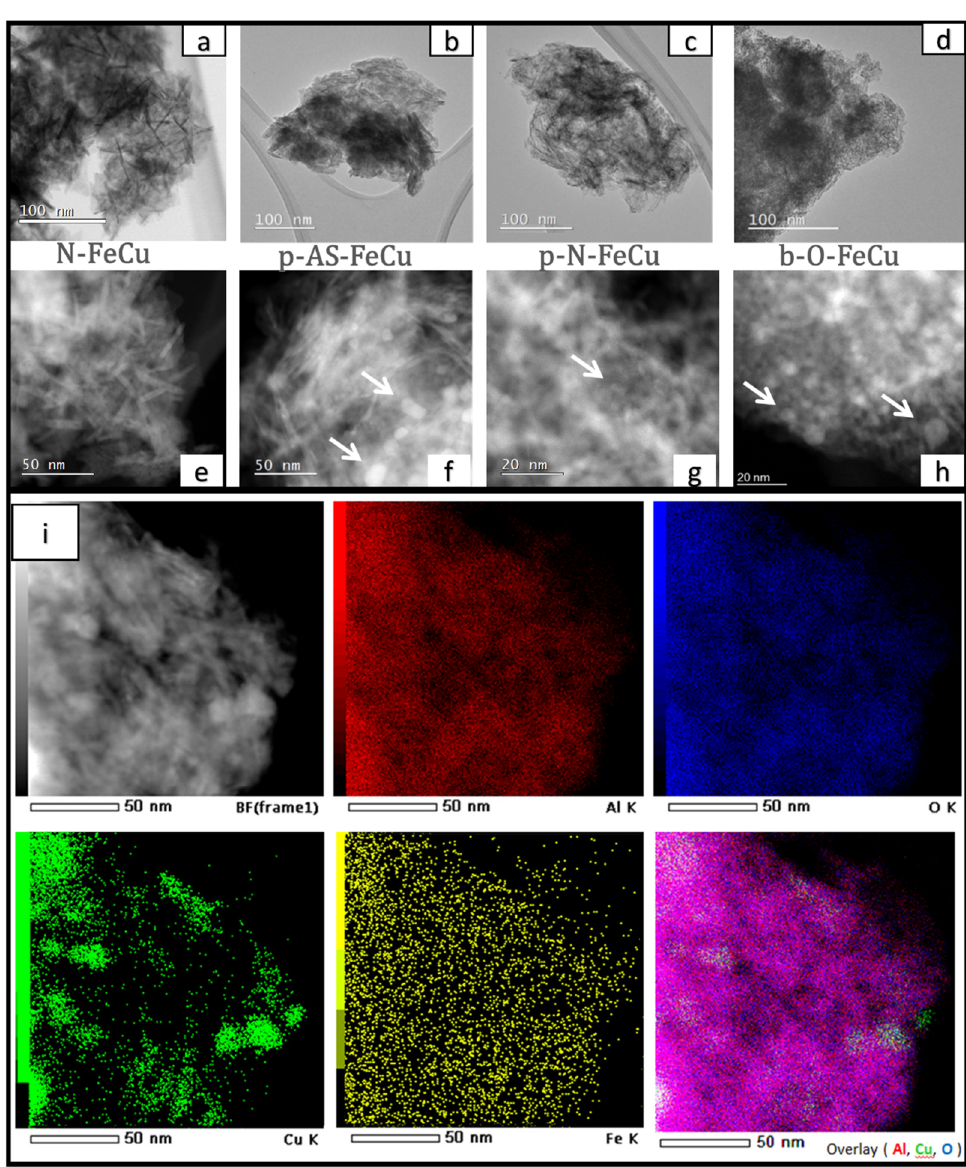
Figure 10. ( a – d ) TEM micrographs of samples “N-FeCu”, “p-AS-FeCu”, “p-N-FeCu” and “b-O-FeCu”, respectively; ( e – h ) HAADF-STEM micrographs of samples showing individual CuO particles. In sample “p-AS-FeCu” and “b-O-FeCu” up to 20 nm sized particles were detected, while in samples “p-N-FeCu” and “N-FeCu” CuO particles are smaller and in lower concentration (in all cases indicated with white arrows). ( i ) EDXS mapping of sample “p-AS-FeCu” where CuO nanoparticles are clearly visible. Iron and copper are uniformly distributed on Al 2 O 3 substrate.